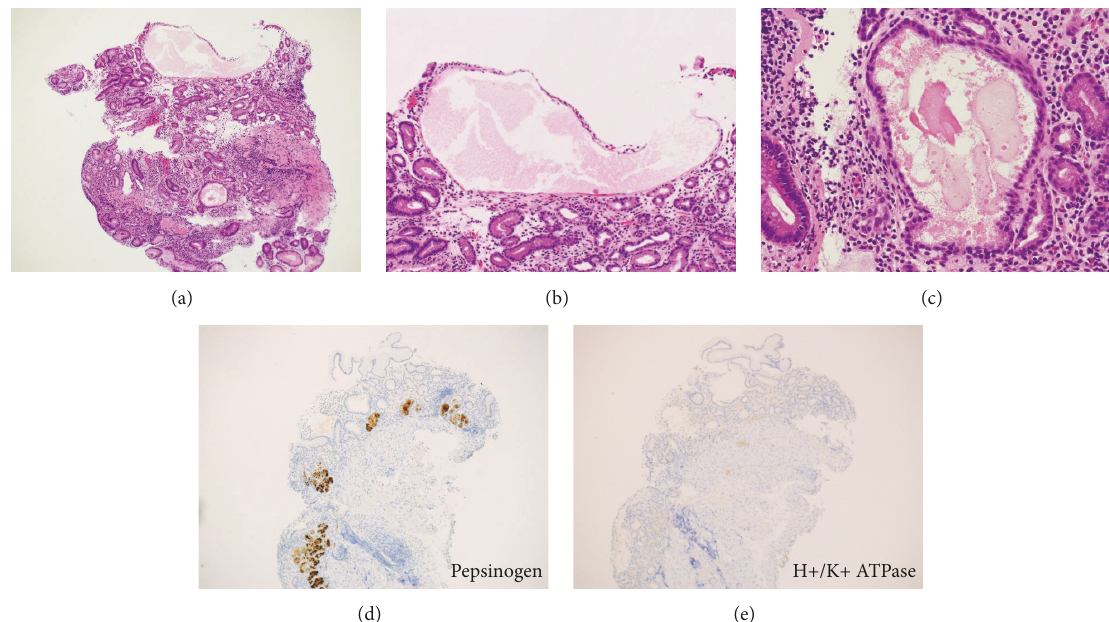
Figure 4: Pathology images of Case 2. Biopsy from the gastric mucosa shows cystically dilated glands (hematoxylin and eosin staining, (a): × 4.2, (b): × 10, (c): × 20). Immunohistochemical study shows that pepsinogen-positive cells ((d), × 4.2) are present, whereas H+/K+ ATPase- positive cells are absent ((e), × 4.2).